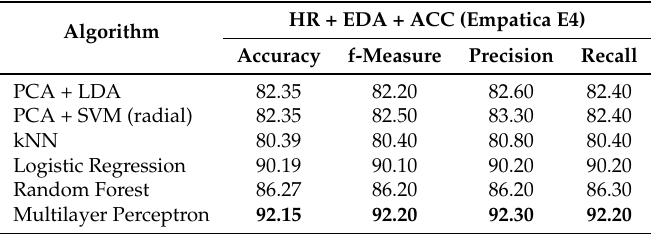
Table 4. Stress with context classification accuracy, f-Measure, precision and recall values with different ML algorithms: three-class. HR + EDA +ACC for Empatica E4.